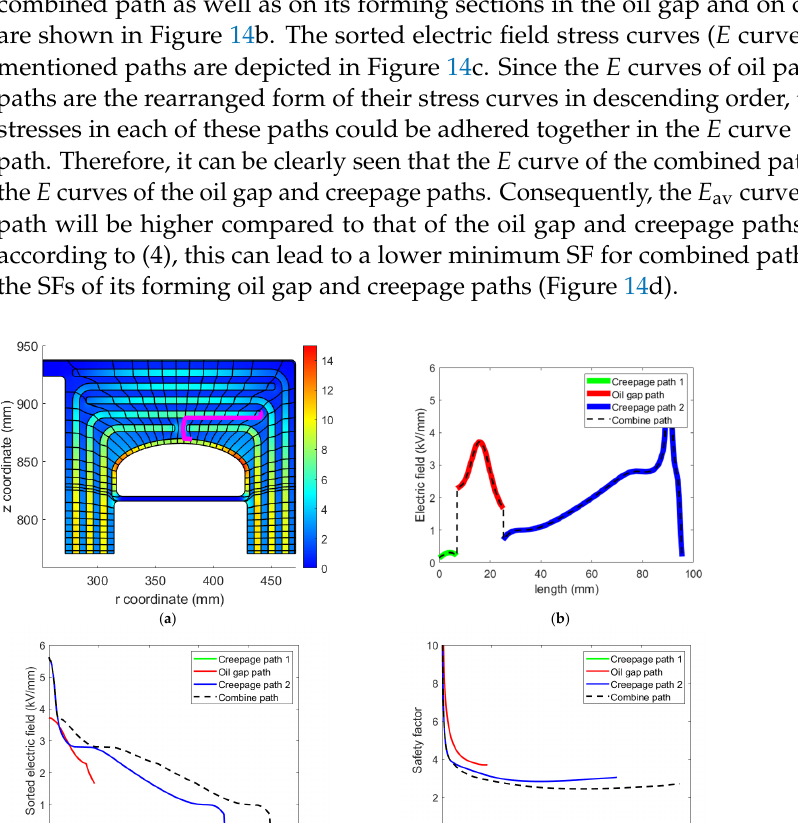
Figure 14. The streamlines by using ester oil at 10 s and 30 °C: ( a ) A sample combined path in an oil gap and two creepage paths (thick pink line, creepage path 1 is on the insulation of the HV shield and creepage path 2 is on the oil duct barrier); ( b ) The electric field curve along this combined path; ( c ) the sorted electric field curves; ( d ) the safety factor curves (the safety factor of the creepage path 1 is higher than 40 and that is why the green line is not shown).